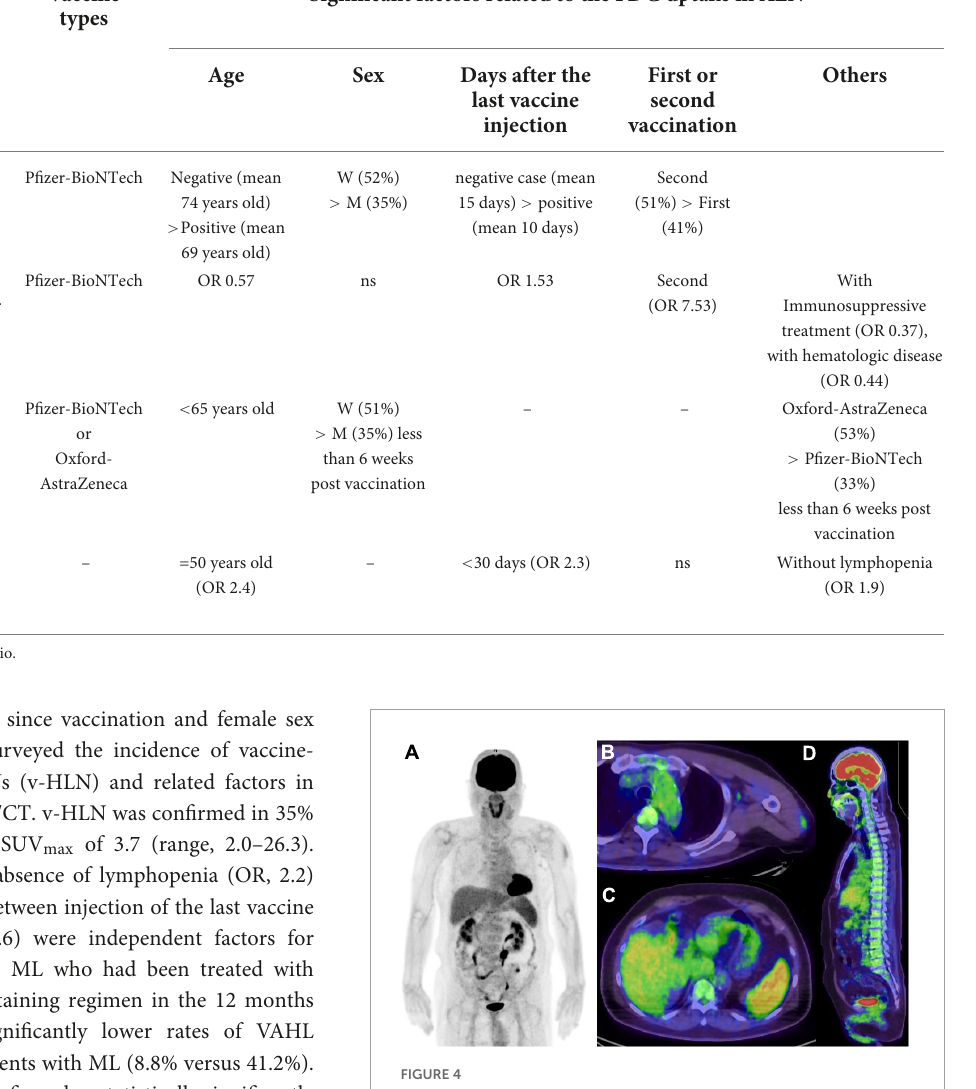
TABLE 1 Significant factors related to the FDG uptake in ALN after COVID-19 vaccination.